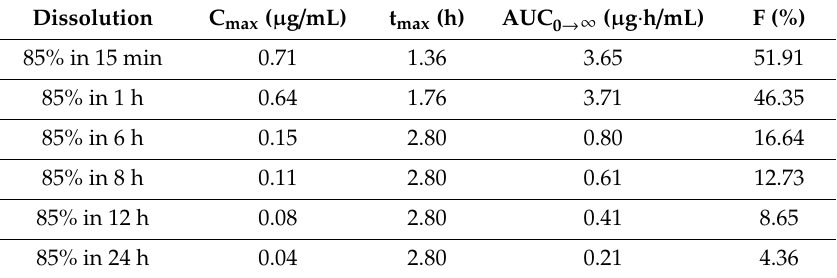
Figure 7. GastroPlus ® simulated furosemide dissolution profiles ( a ); and ( b ) the corresponding simulated plasma profiles; ( c ) absorption profiles; and ( d ) regional absorption distribution. Table 5. GastroPlus ® predicted pharmacokinetic parameters for di ff erent furosemide virtual dissolution profiles from 40 mg p.o. dosage